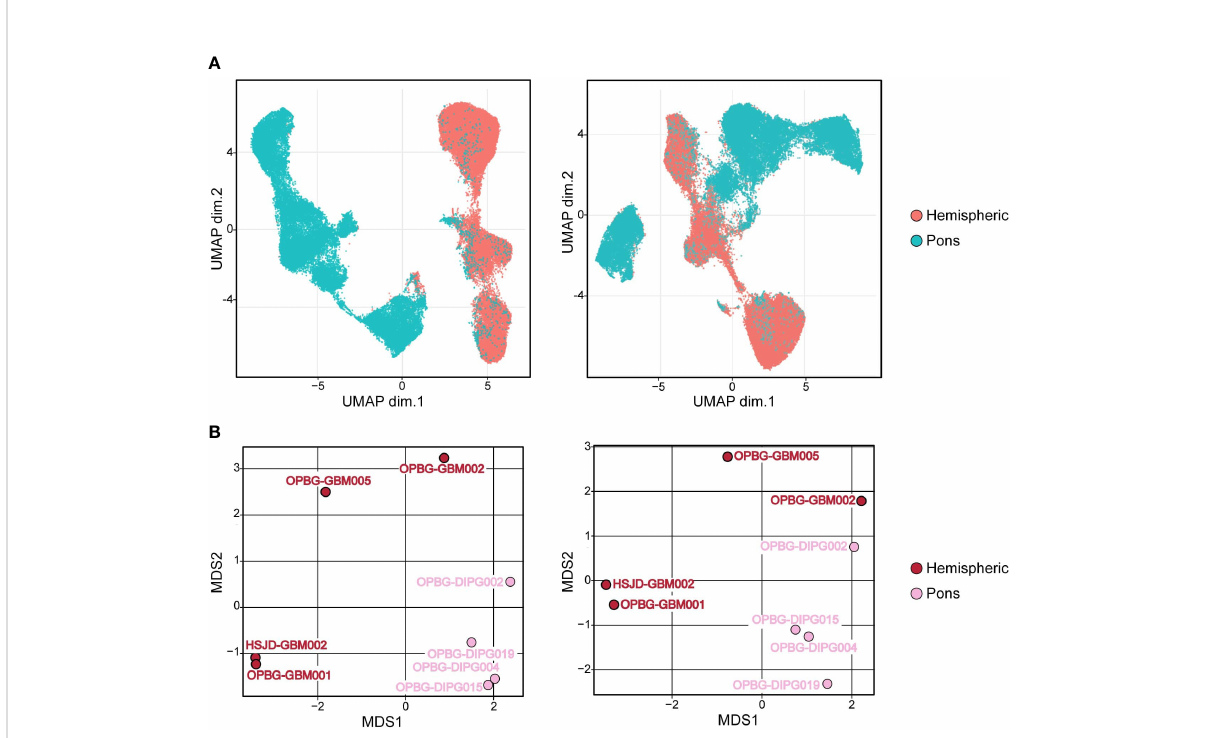
FIGURE 6 Hemispheric and pons patient-derived cell line separation. (A) UMAP projections and (B) Multidimensional Scaling plot (MDS) of PDHGG patient- derived cell lines obtained by including (left) or not (right) H3.3G34R and H3K27M histone variants in the relative analysis performed on single- cell mass cytometry data. The color refers to the locational subgroup to which the PDHGG patient-derived cell lines belong (hemispheric or pons, see the relative key